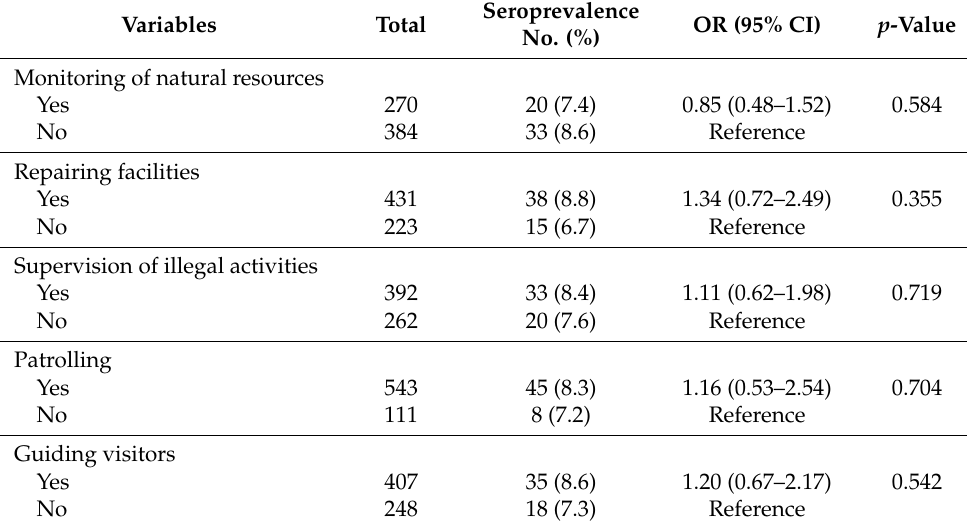
Table 3. Univariate logistic regression analysis between work type and Lyme disease seroprevalence among National Park Office forestry workers in South